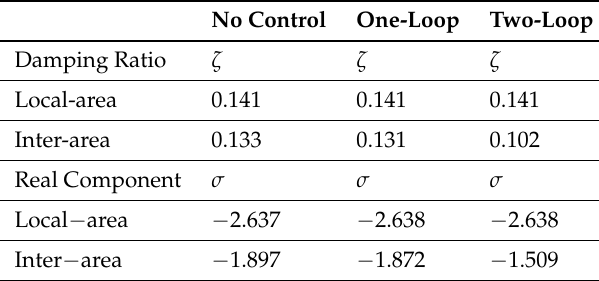
Table 4. Scenario 3—Weak